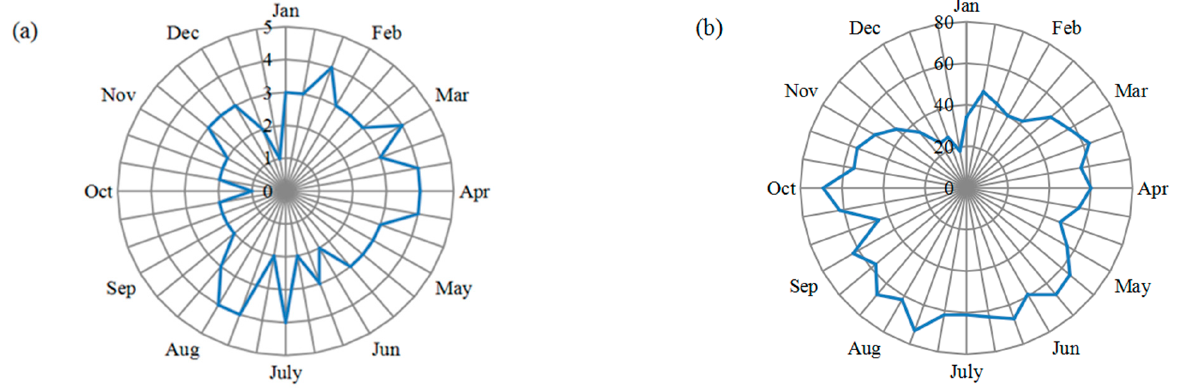
Figure 7. Beginning of drought process ( a : stations/year) and multi-year mean of average duration ( b : days).